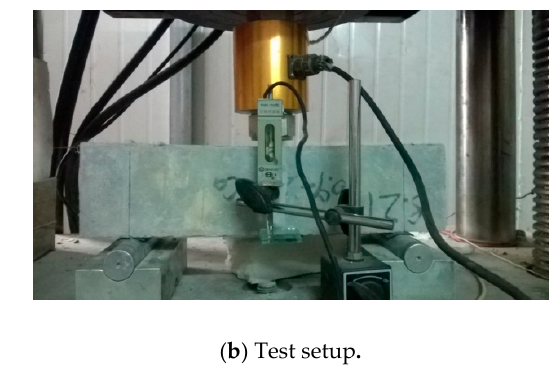
Figure 4. Three-point bending test.